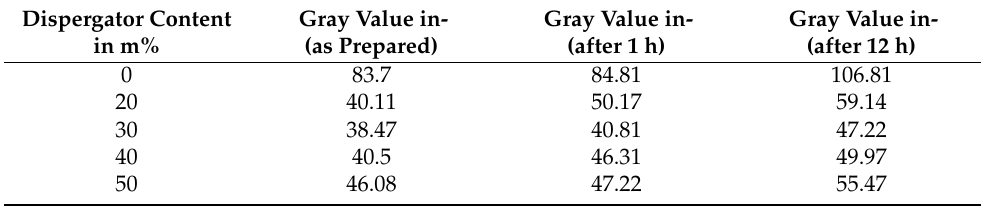
Table A16. Gray values of CB dispersions as a function of TX-100 content at different times. Dispergator Content Gray Value in m%